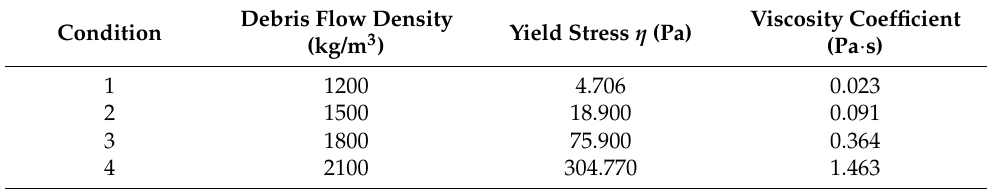
Table 1. Numerical simulation parameters of the Bingham debris